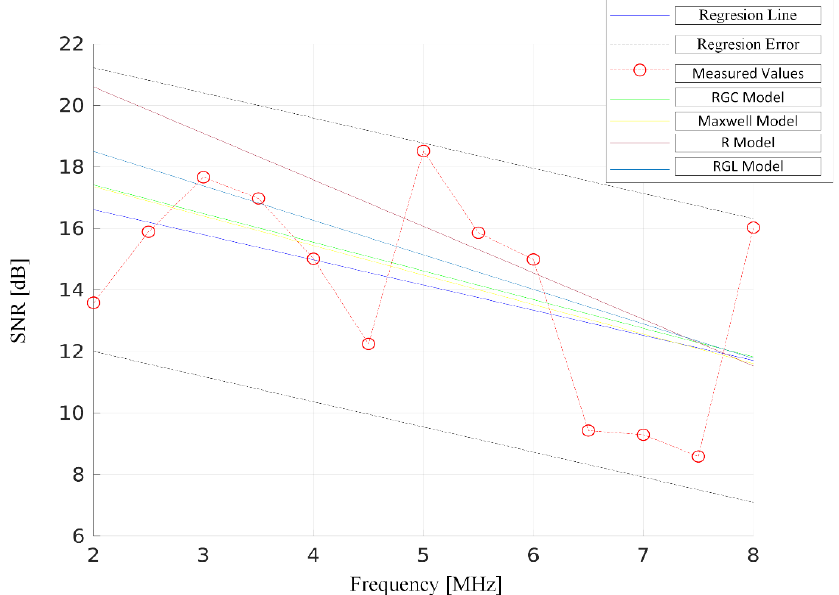
Figure 4. Relation between SNR and frequency for different cable models for inductive – inductive coupling.